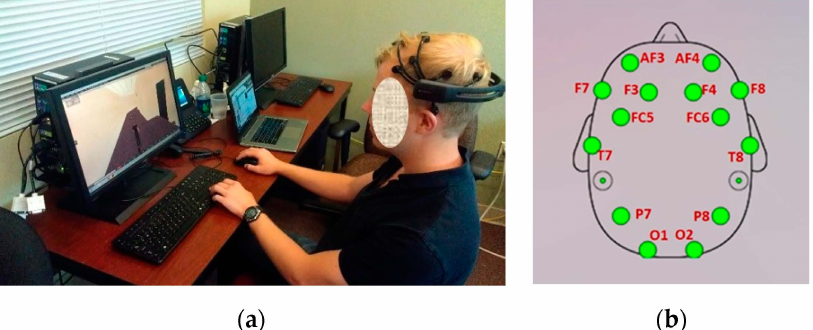
Figure 4. EEG recording: ( a ) Participant undergoing VSW training wearing EEG headset; ( b ) channels mapping of 14 electrodes as per 10–20 international system.